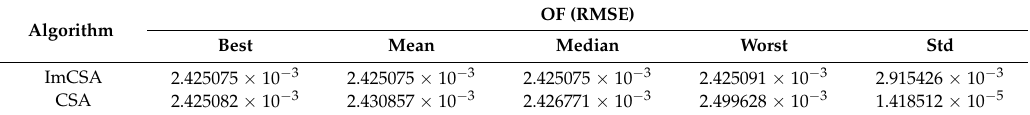
Table 7. Statistics of the OF (RMSE) values for the PMM of Photowatt-PWP201 module using the proposed ImCSA and CSA.